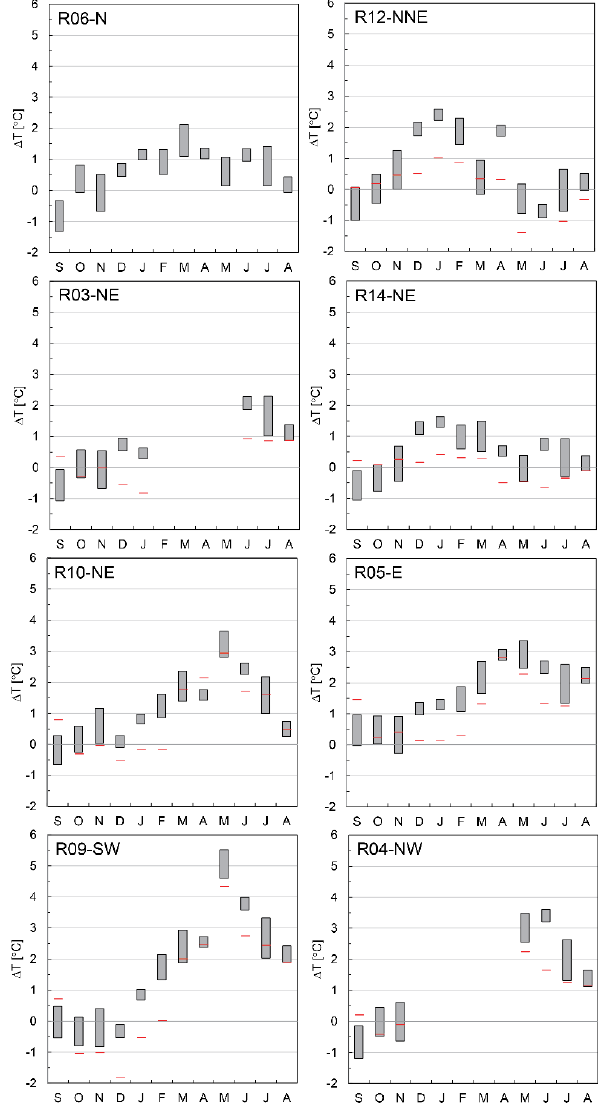
Figure 10. Monthly temperature difference ( (cid:49)T ) between calcu- lated air temperature and measured rock face temperatures from 2009-2013. Calculated air temperature is based on air temperature from Signaldalen (65ma.s.l.) and the lapse rates shown in Fig. 9. Boxes show the interquartile range of (cid:49)T . The red horizontal lines show the monthly-mean temperature difference between the respec- tive loggers and the north facing (i.e. the coldest) logger R06. Log- gers R03, R04, and R12 were snow covered during winter and data from snow-influenced months were removed. For R09 and R10 only data for 2009–2011 exist, for R12 and R14 only for